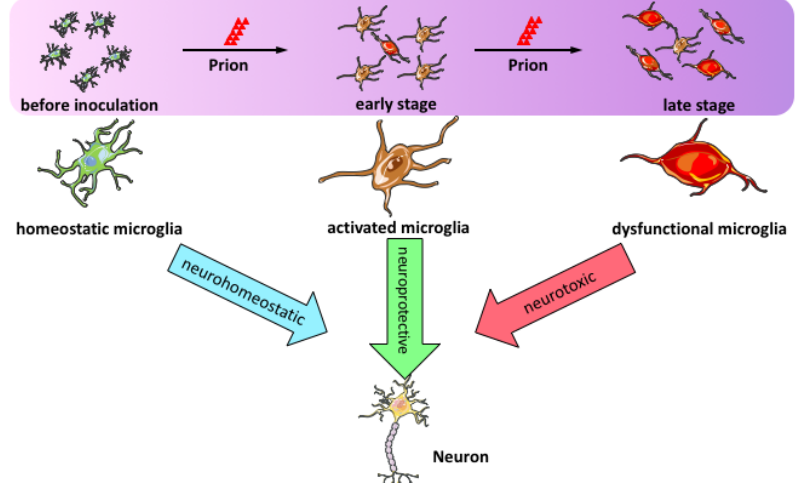
Figure 1. Microglial activation in prion disease. During prion disease progression, microglial activation is a complex and multistep process. Activated microglia consist of a heterogeneous population with distinct functions. At early stages, most microglia respond to prion infection and consequently enhance their phagocytic capacity to clear PrP Sc . Therefore, activated microglia at this stage are neuroprotective. However, the phagocytosis and clearance function are insufficient and sustained PrP Sc accumulation causes neuronal damage, which could stimulate microglia to switch to a dysfunctional pro-inflammatory phenotype and elicit a detrimental effect in the brain.